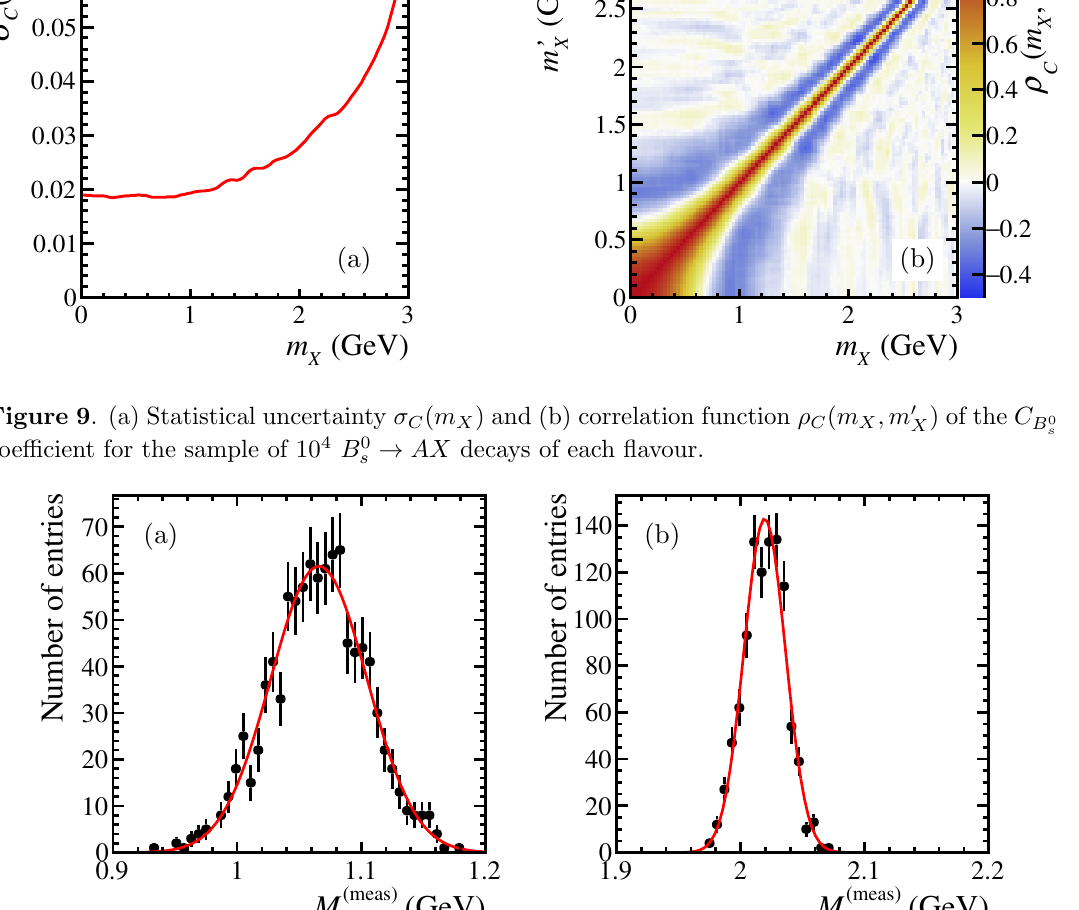
Figure 10 . Distributions of the X mass estimate M (meas) the S ( m X ) function for true X mass (a) M X = 1 GeV and (b) M X = 2 GeV. Smooth line is the B 0 s result of the Gaussian